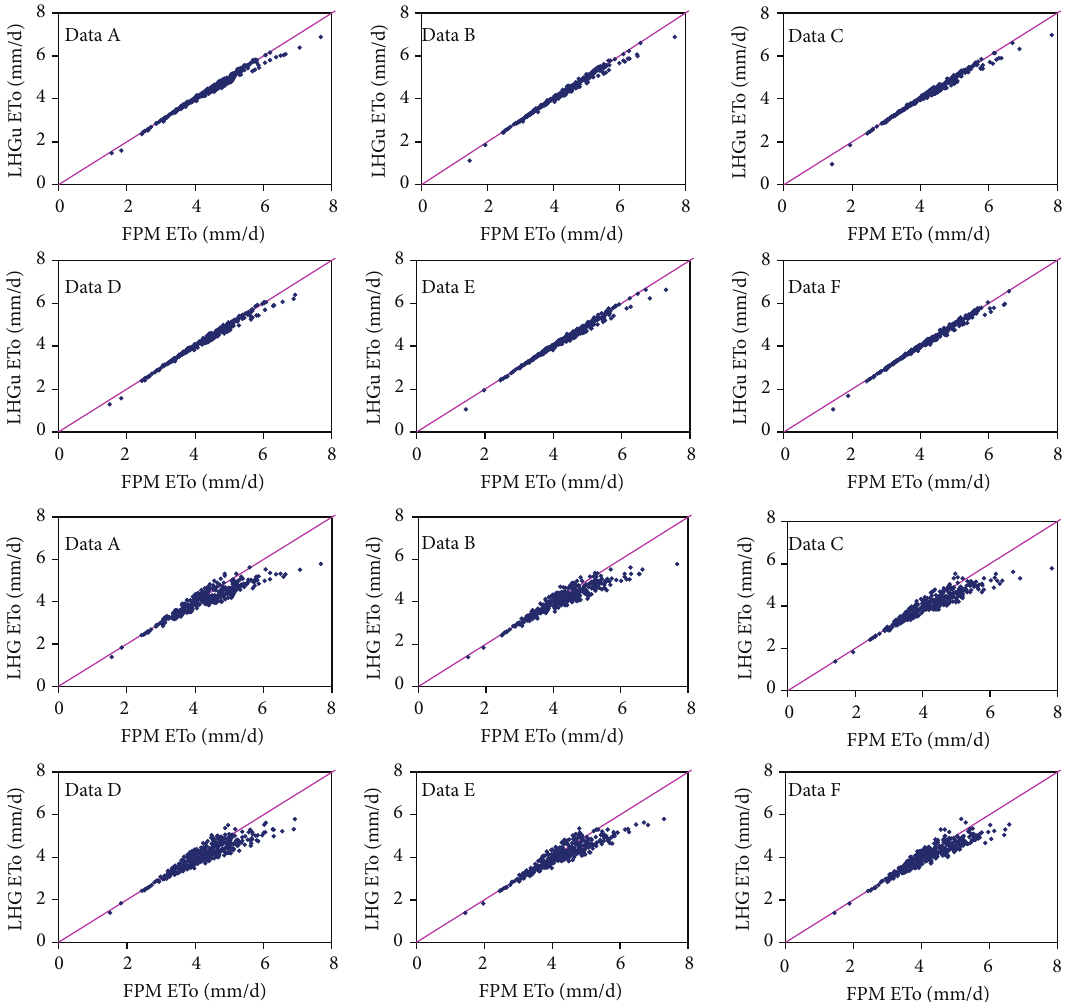
Figure 4: LHGu matched FPM far more precisely than LHG when applied to six different simulated mixed uniform daily 𝑢 2 data ranging 0.5–6.0 m/s and 2007 Accra site temperature data. Table 4: Performance parameters of LHGu and LHG against FPM when applied to six different simulated mixed 𝑢 2 data in the range 0.5– 6.0 m/s and 2007 weather data for the Accra site.